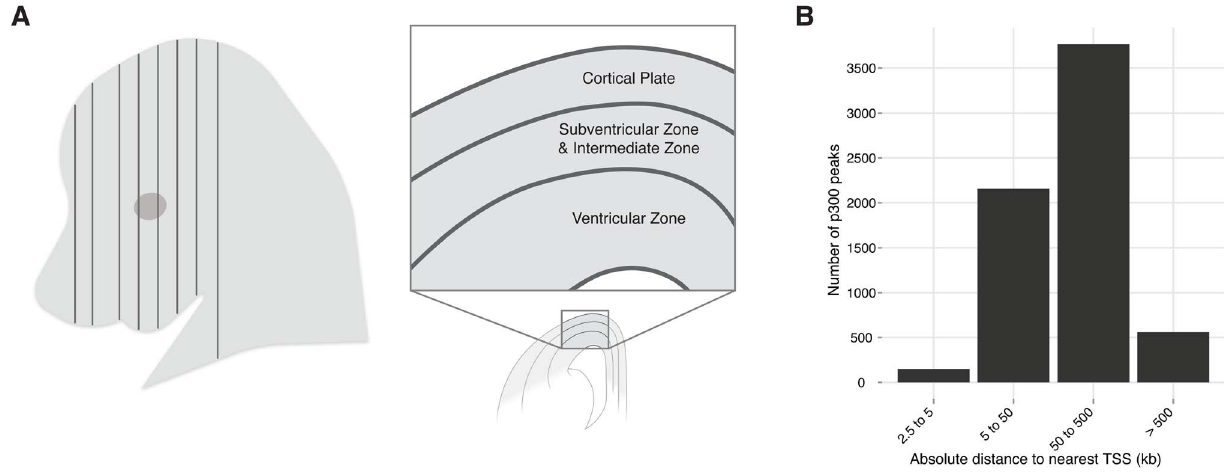
Figure 1. Neocortex development and evolution. A) A coronal plane of section through an embryo. One hemisphere is shown diagrammatically. The neocortex develops from the dorsal telencephalon. At E14.5 progenitor cells from the ventricular zone (VZ) are producing intermediate progenitor cells that migrate to form the subventricular and intermediate zones (SVZ-IZ); daughter cells from both areas migrate past the SVZ-IZ to form the cortical plate (CP), from which the neocortex develops (adapted from [7]). B) Absolute distance of the 6,629 p300 peaks (midpoint) to the canonical transcription start site of the nearest gene.